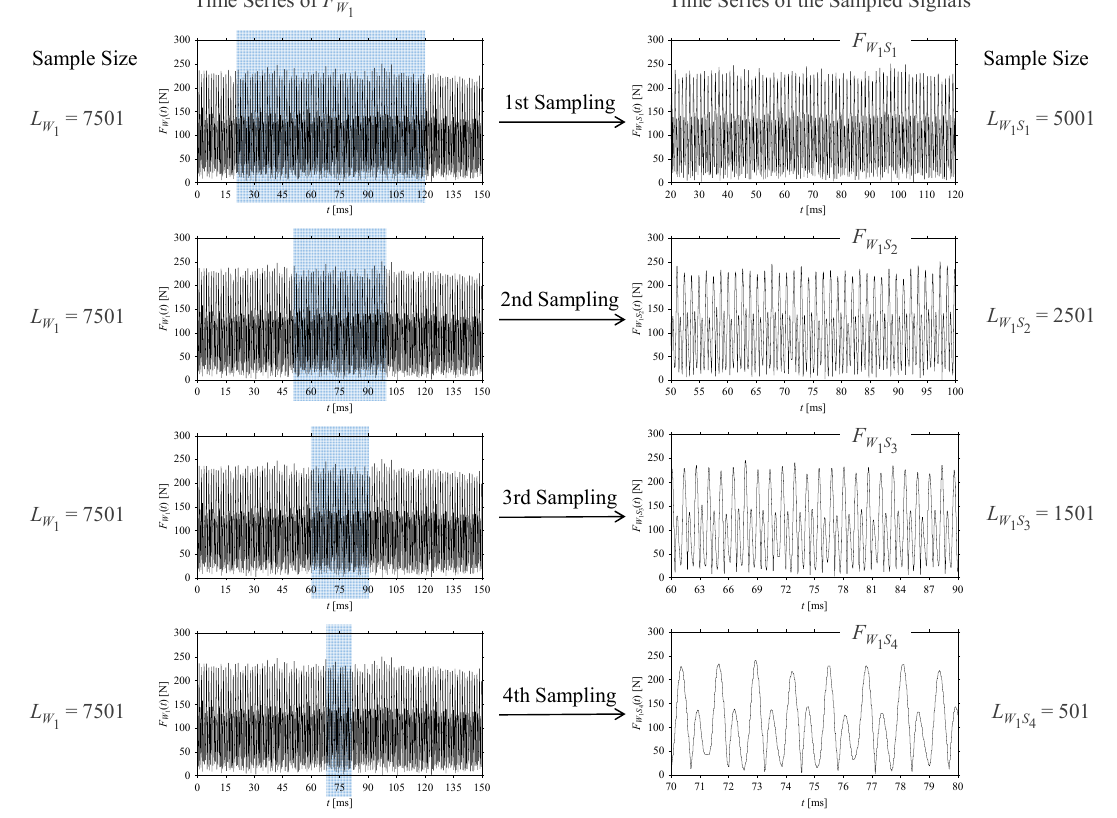
Figure 7. Sampling the cutting force signal for machining stainless steel (SUS304).